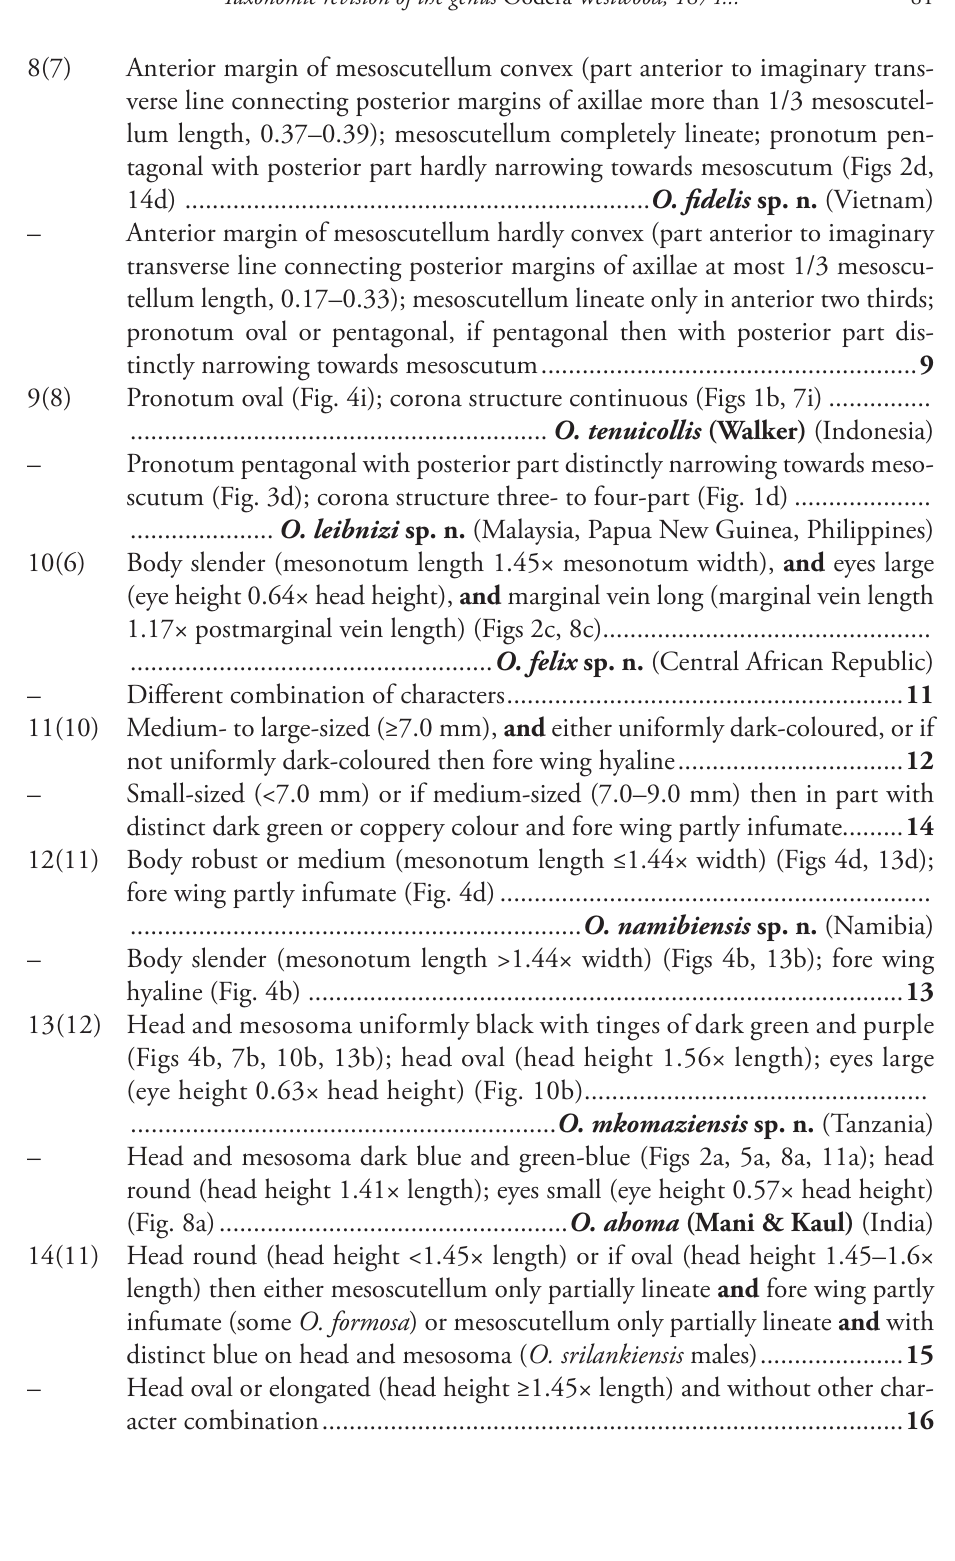
Anterior margin of mesoscutellum convex (part anterior to imaginary trans- verse line connecting posterior margins of axillae more than 1/3 mesoscutel- lum length, 0.37–0.39); mesoscutellum completely lineate; pronotum pen- tagonal with posterior part hardly narrowing towards mesoscutum (Figs 2d, 14d) .................................................................... O. fidelis sp. n. (Vietnam) – Anterior margin of mesoscutellum hardly convex (part anterior to imaginary transverse line connecting posterior margins of axillae at most 1/3 mesoscu- tellum length, 0.17–0.33); mesoscutellum lineate only in anterior two thirds; pronotum oval or pentagonal, if pentagonal then with posterior part dis- 9(8) Pronotum oval (Fig. 4i); corona structure continuous (Figs 1b, 7i) ............... – Pronotum pentagonal with posterior part distinctly narrowing towards meso- scutum (Fig. 3d); corona structure three- to four-part (Fig. 1d) .................... 10(6) Body slender (mesonotum length 1.45× mesonotum width), and eyes large (eye height 0.64× head height), and marginal vein long (marginal vein length 1.17× postmarginal vein length) (Figs 2c, 8c)................................................